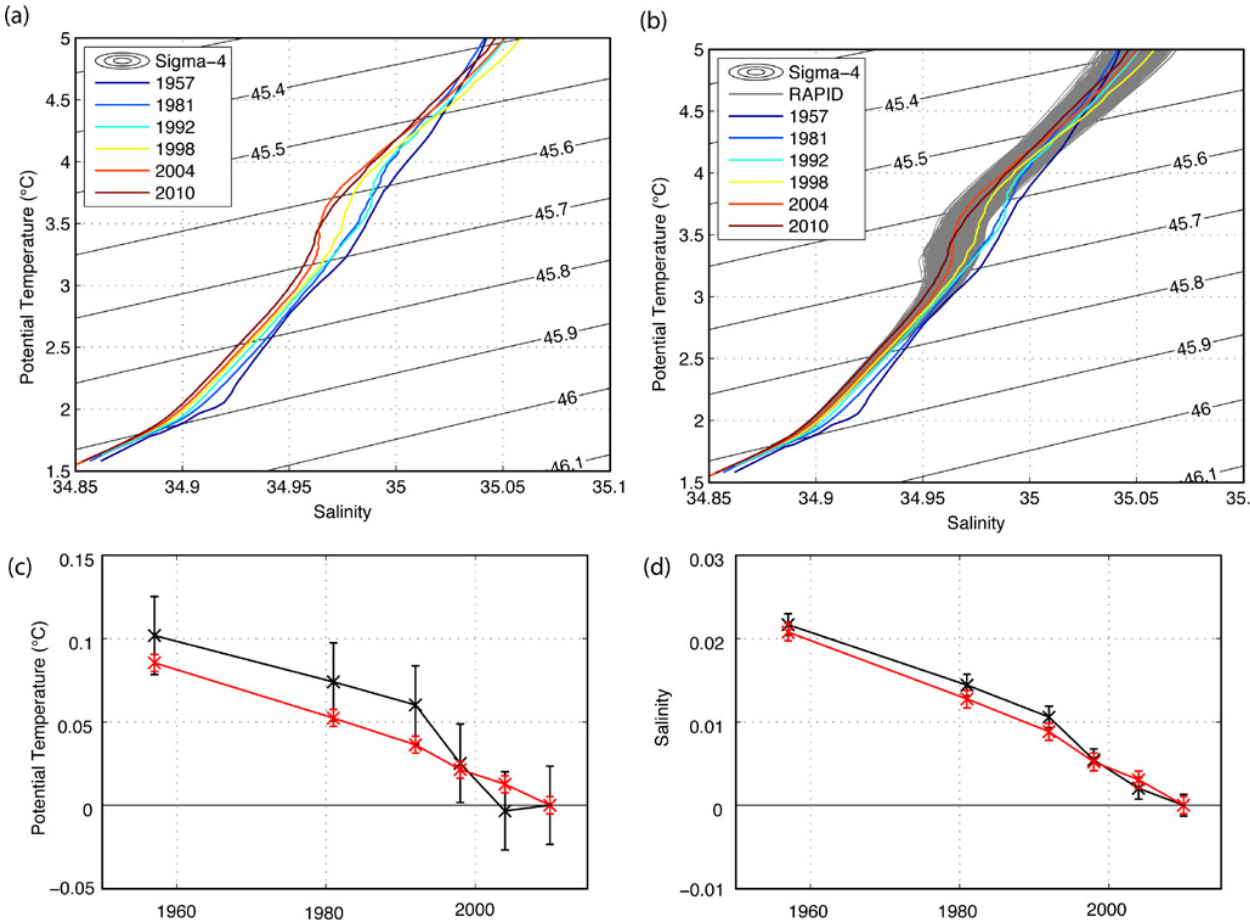
Fig. 13. Top ( a – b ), θ -S plots of water mass properties averaged over the longitudinal range 77 ◦ W–70 ◦ W for the six hydrographic sections in the the upper and lower North Atlantic Deep Waters (a) , and with all twice daily Rapid-WATCH profiles (2004–2009) overlaid (b) . The Rapid-WATCH profiles shown are the average of moorings WB3 and WB5 (see text). σ 4 potential density surfaces are shown. Bottom ( c – d ), potential temperature (c) and salinity (d) changes in the LNADW (3000–4700m depth range) for the six hydrographic sections averaged over 77 ◦ W–70 ◦ W. Changes are shown relative to 2010. Black lines denote changes on depth surfaces and red lines denote changes on potential density surfaces ( σ 4 ). Error-bars denote ± 1std. dev. of property variability calculated from de-trended Rapid-WATCH mooring data (2004–2009, average of WB3 and WB5, see